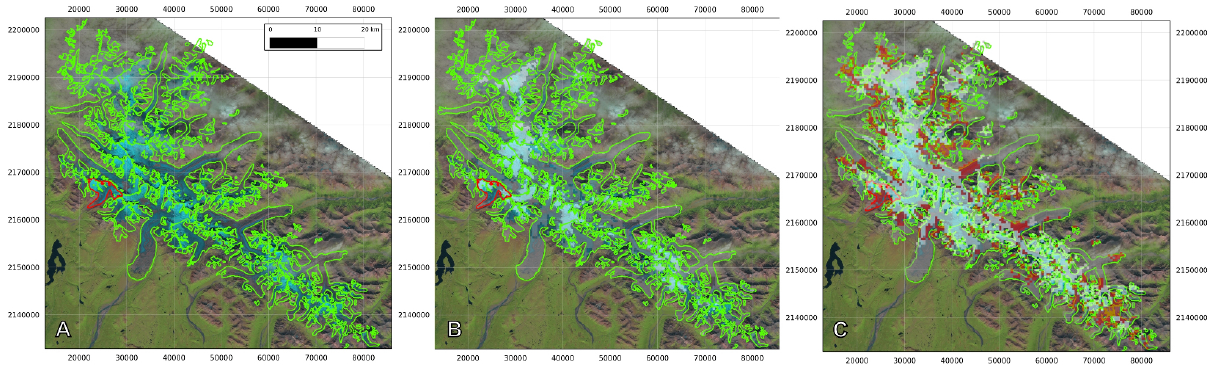
Fig. 6: (A) Landsat 5 scene of the eastern Alaska Ranges, 15 August 2004, with (B) 22 August 2004 MOD02 snow (white) and ice (grey) clusters, and (C) 22 August 2004 MOD10 snow cover product. Cloud-obscured pixels in (C) are shown in red. Fig. 6. (A) Landsat 5 scene of the eastern Alaska Ranges, 15 August 2004, with (B) 22 August 2004 MOD02 snow (white) and ice (grey) Fig. 6 : A) Landsat 5 scene of the eastern Alaska Ranges, 15 August 2004, with (B) 22 August Gulkana Glacier is highlighted in red. clusters, and (C) 22 August 2004 MOD10 snow cover product. Cloud-obscured pixels in (C) are shown in red. Gulkana Glacier is highlighted Fig. 6 : A) Landsat 5 scene of the eastern Alaska Ranges, 15 August 2004, with (B) 22 August 2004 MOD02 snow (white) and ice (gray) clusters, and (C) 22 August 2004 MOD10 snow in red. 2004 MOD02 snow (white) and ice (gray) clusters, and (C) 22 August 2004 MOD10 snow cover product. Cloud-obscured pixels in (C) are shown in red. Gulkana Glacier is highlighted cover product. Cloud-obscured pixels in (C) are shown in red. Gulkana Glacier is highlighted in red. in red.